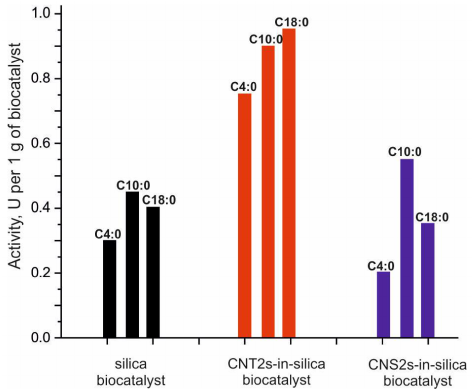
Figure 9. Activity of r E. coli /lip lysate-based biocatalysts and the nanocarbons-in-silica composites in reaction of esterification of fatty acids such as butyric C4:0, capric C10:0 and stearic C18:0 with isopentanol. Reaction conditions: 20 ◦ C, 0.1 M fatty acid, 0.2 M isopentanol, hexane and diethyl ether in ratio 1:1. Reactions were performed in six